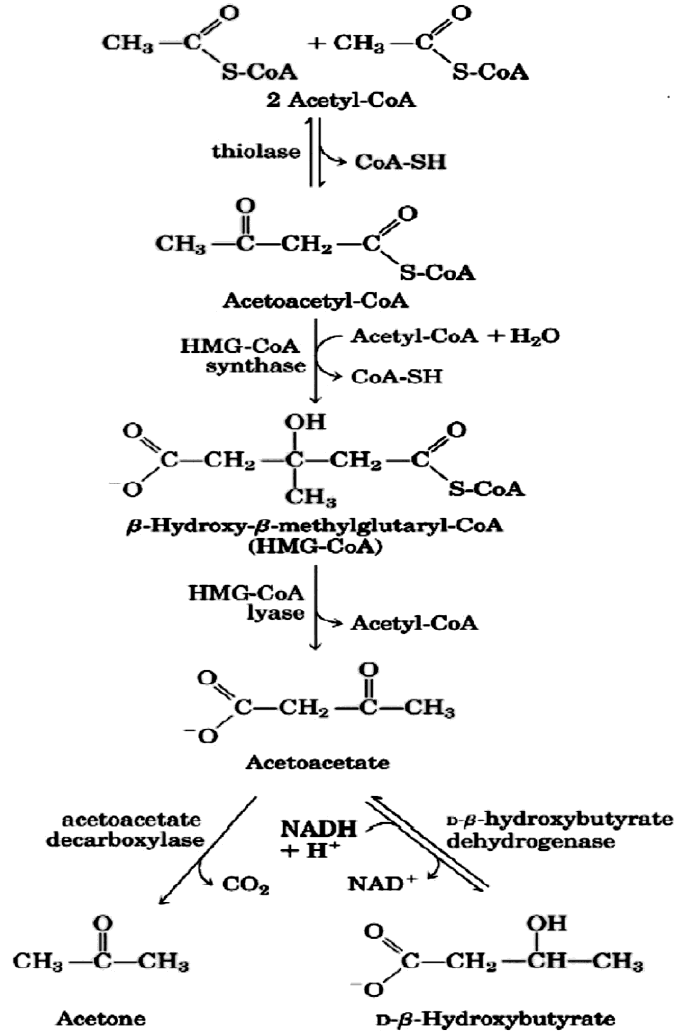
Figure 2. Pathway of ketone bodies’ formation from